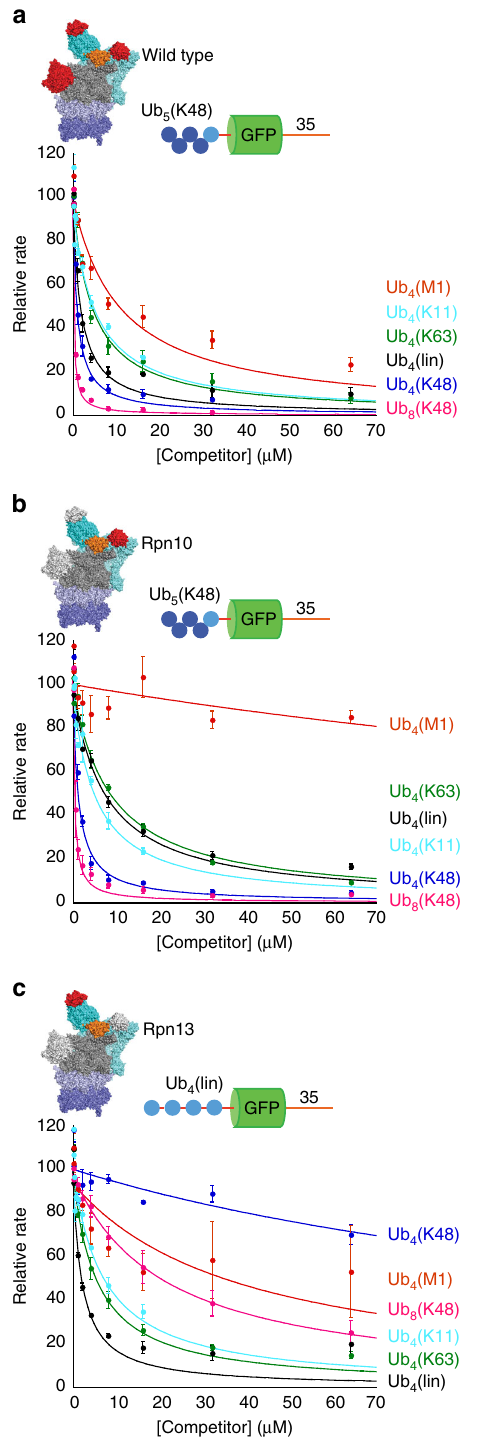
(Fig. 6, Supplementary Table 4; i.e., had higher k cat / K M